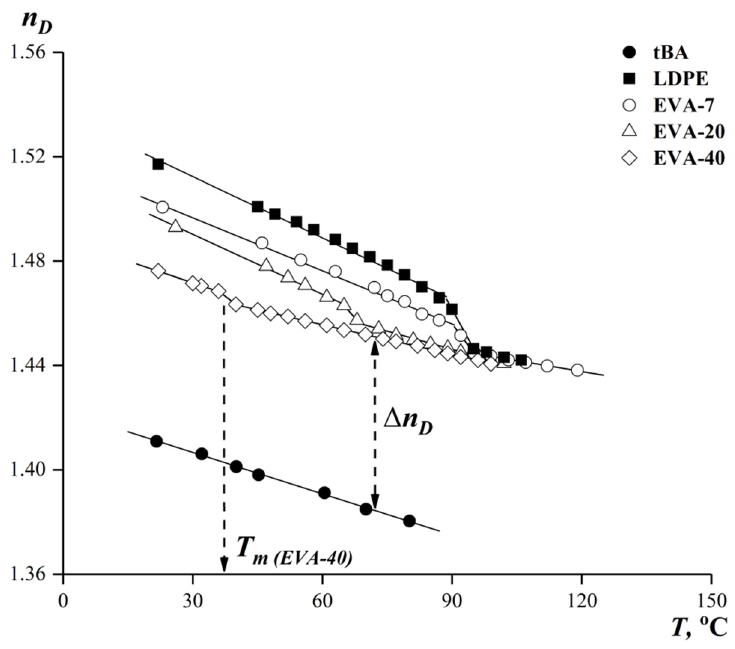
Figure 2. Temperature dependences of the refractive index of tBA, LDPE, EVA ‐ 7, EVA ‐ 20, EVA ‐ 40.